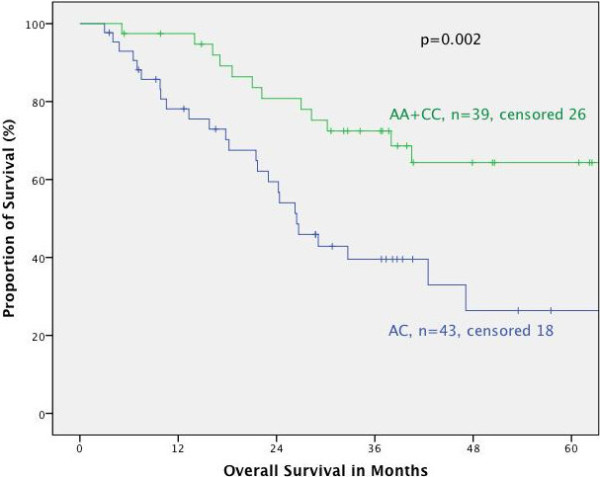
Survival in gastric cancer patients according to UICC 7th edition, MTHFR A1298C AC versus AA/CC. Legend: Subgroup analysis for patients with adenocarcinoma of the stomach dependent on polymorphisms of MTHFR A1298C, comparing AC genoytpe to AA and CC genotype. Median Survival times: AA/CC not reached, AC 26.5 months, p = 0.002.